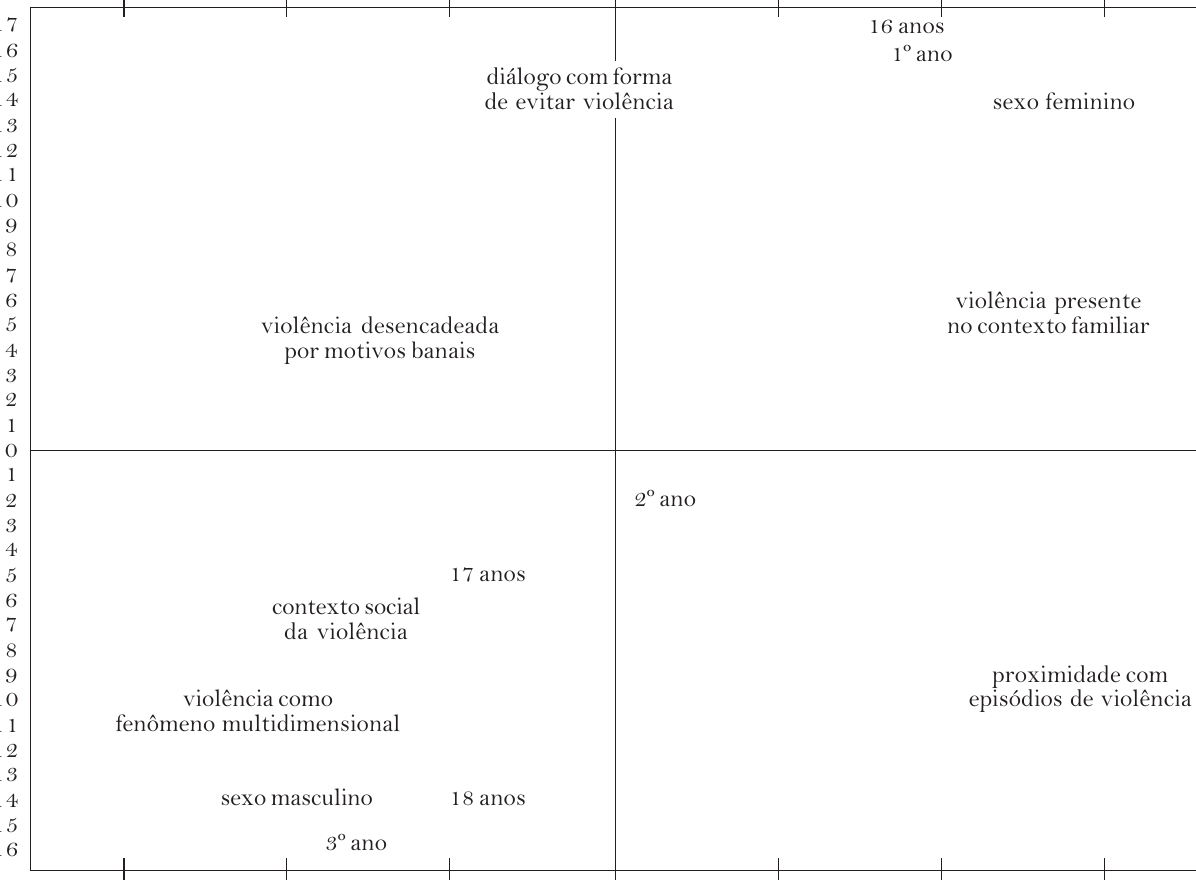
Figura 2. Plano Fatorial com a projeção das classes e variáveis